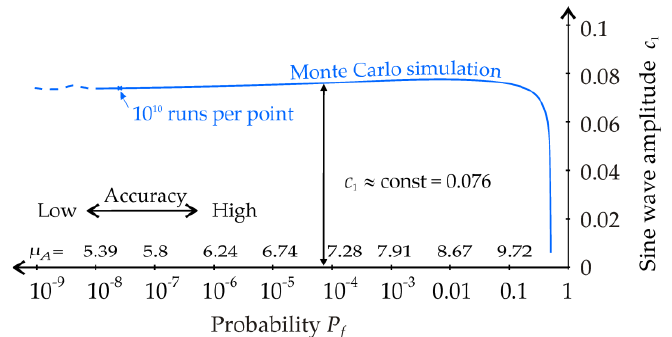
Figure 10. Parameter of pseudorandom model uncertainty — case study 4.